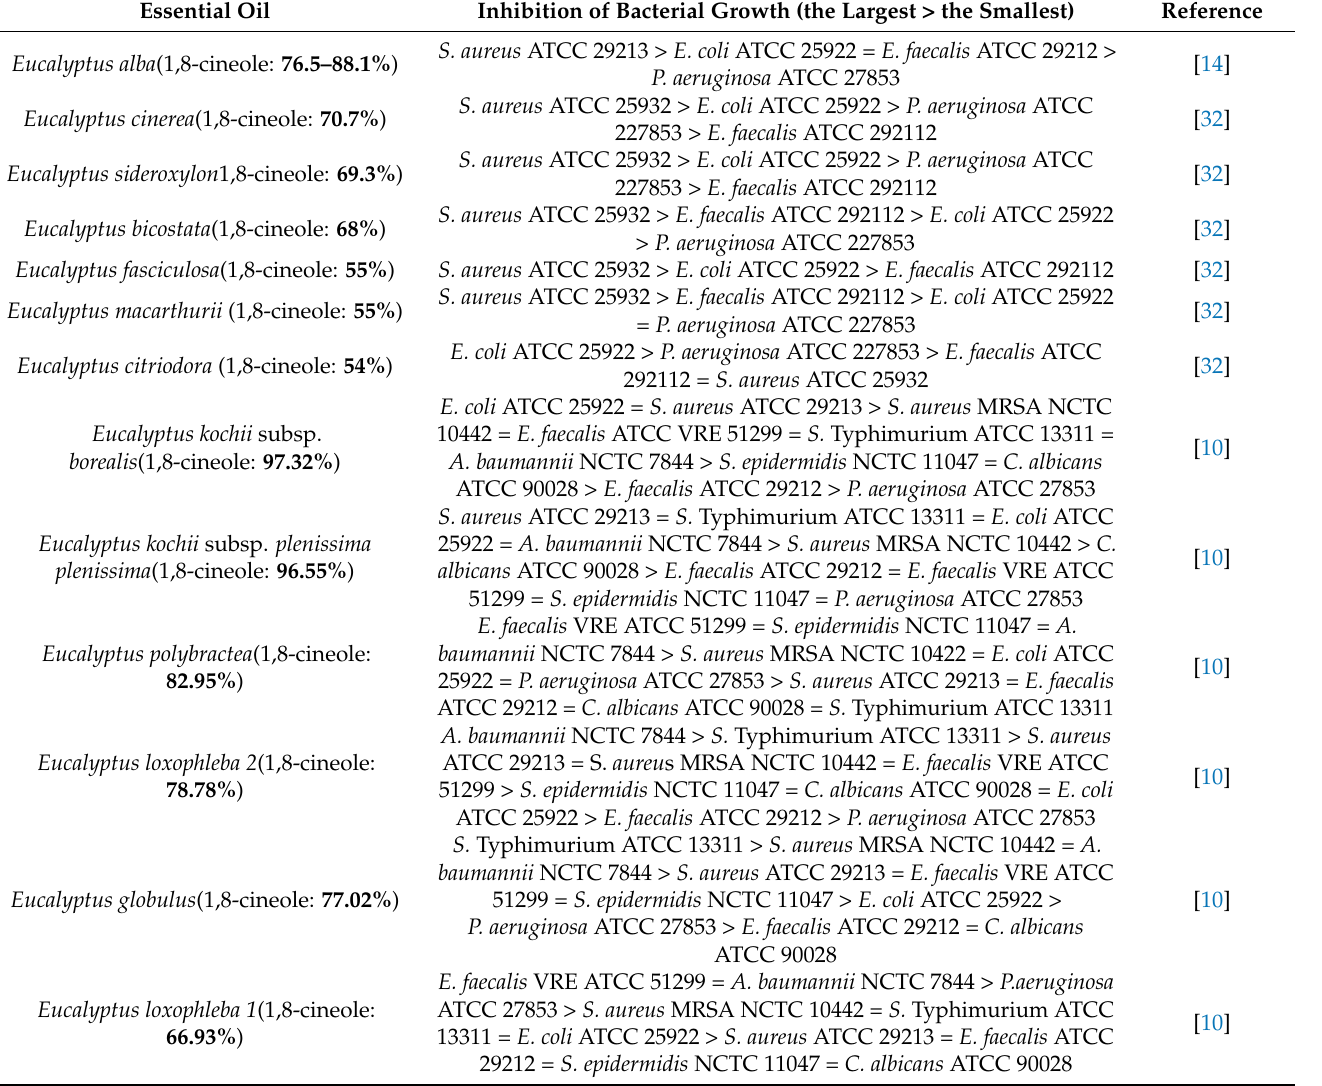
Table 2. Antibacterial activity of 1,8-cineole depending on its content in various